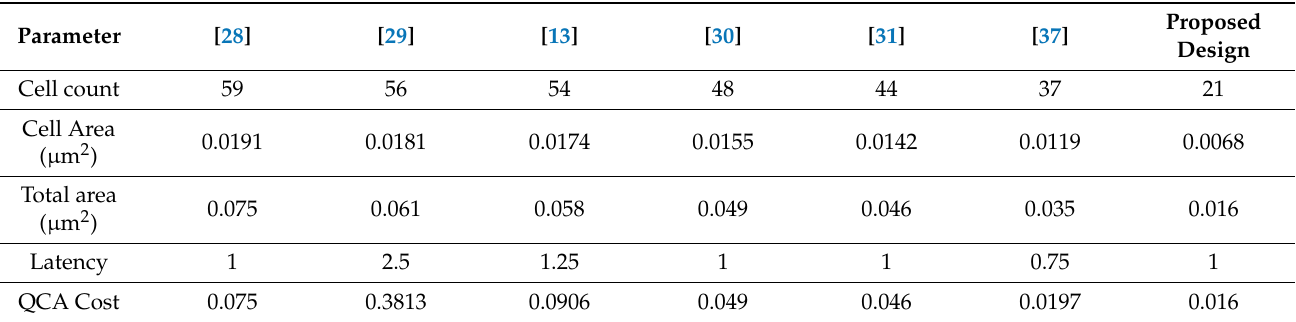
Table 6. Performance comparison of proposed DFF.